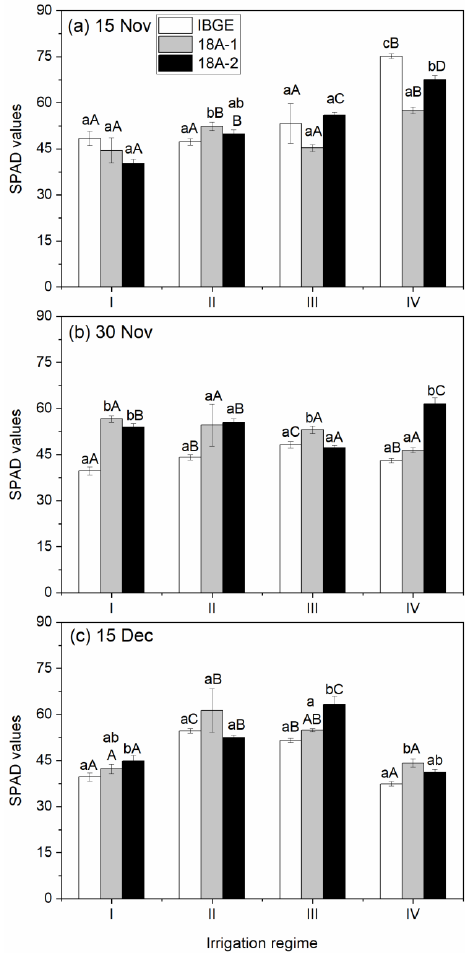
Figure 3. Effects of irrigation regimes on SPAD values of wheat cultivars sown on different dates. Bars show mean values of six replicates from two growth cycles and contain standard errors of means ( n = 6). In each panel, bars under each irrigation regime with different lowercase letters show significant differences between wheat cultivars, and bars of each cultivar with different uppercase letters show significant differences between irrigation regimes at p < 0.05. I — irrigation at tillering stage; II — irrigations at tillering and booting stages; III — irrigations at tillering, booting, and flowering stages; IV — irrigations at tillering, booting, flowering, and grain filling stages. Nov=November, Dec=December.